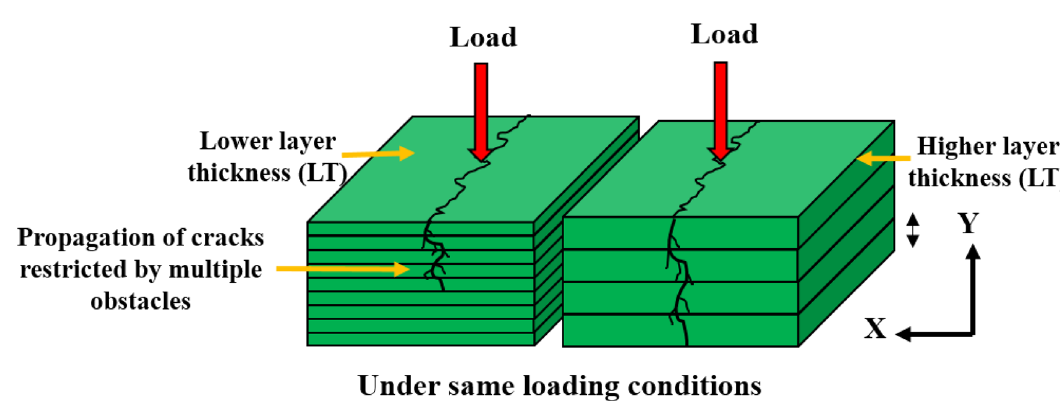
Figure 11. Schematic representation of bonding mechanism.